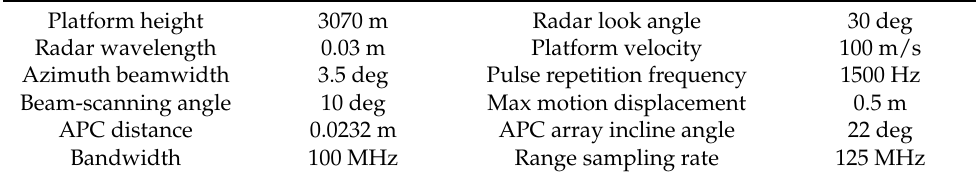
Table 1. TOPS SAR slant range error simulation